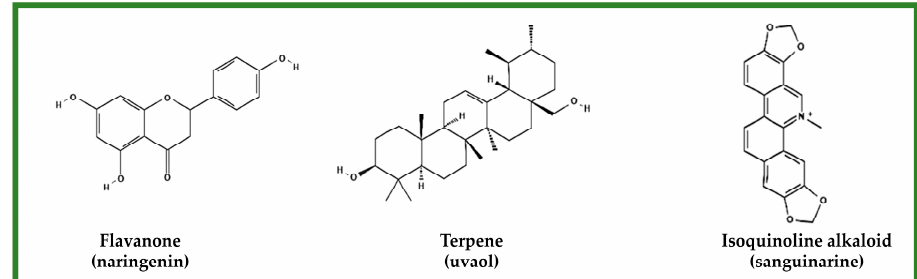
Figure 3. Example of the compounds from natural products evaluated for their in vitro wound heal- ing effect.